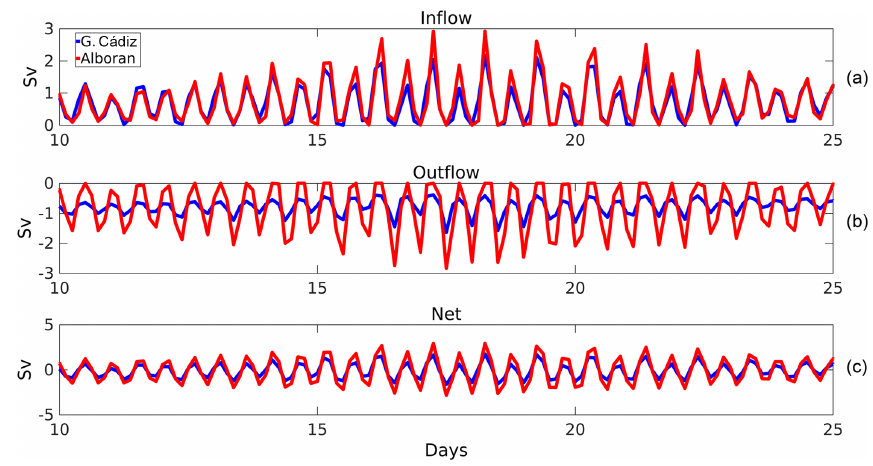
Figure 3. Fifteen-day time series subset during a typical spring tide period showing the 3-hourly transports computed from the tidal run at the outer sections, Gulf of Cádiz (westernmost section, in blue) and Alboran (easternmost section, in red). The inflow (a) , outflow (b) and net transport (c) are shown.